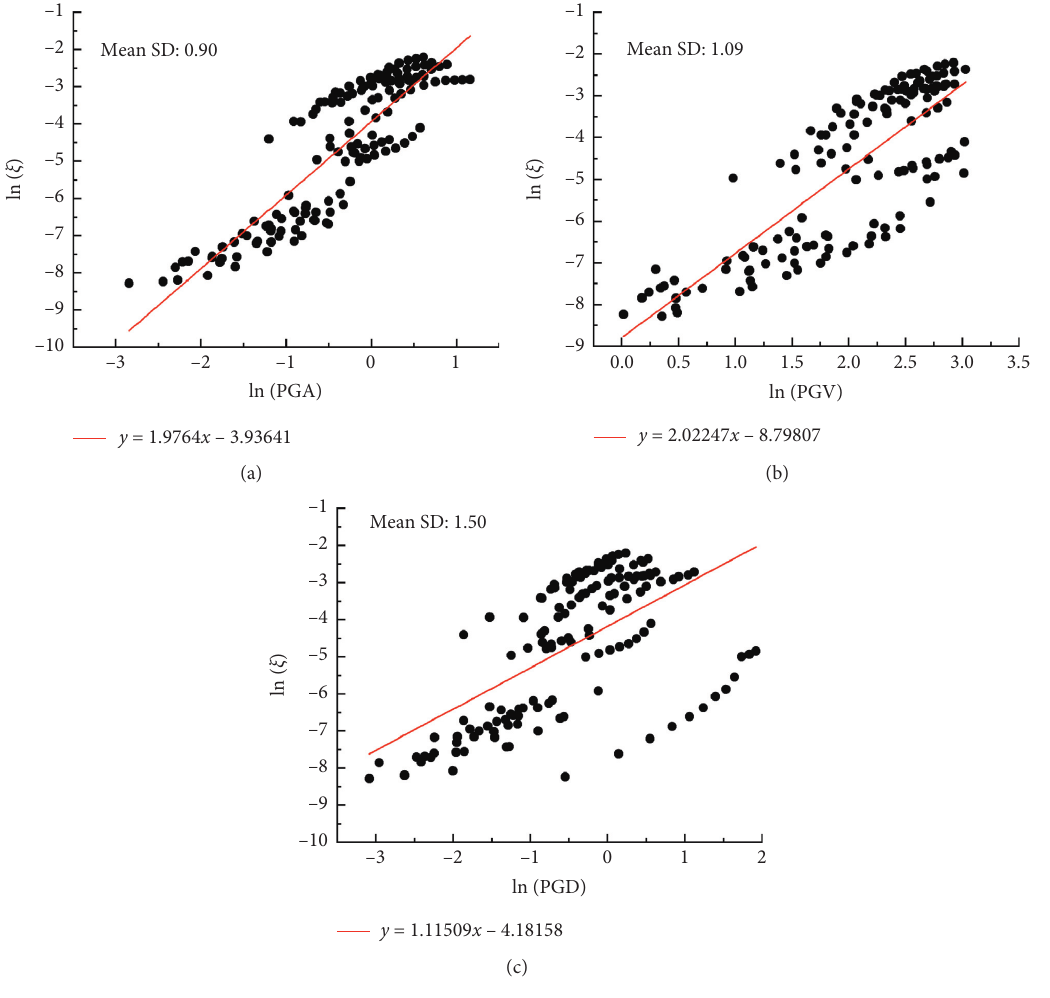
Figure 8: The regression fitting of different IM indicators: (a) PGA; (b) PGV; (c) PGD. Table 5: Three-level fortification requirements and its control index thresholds.